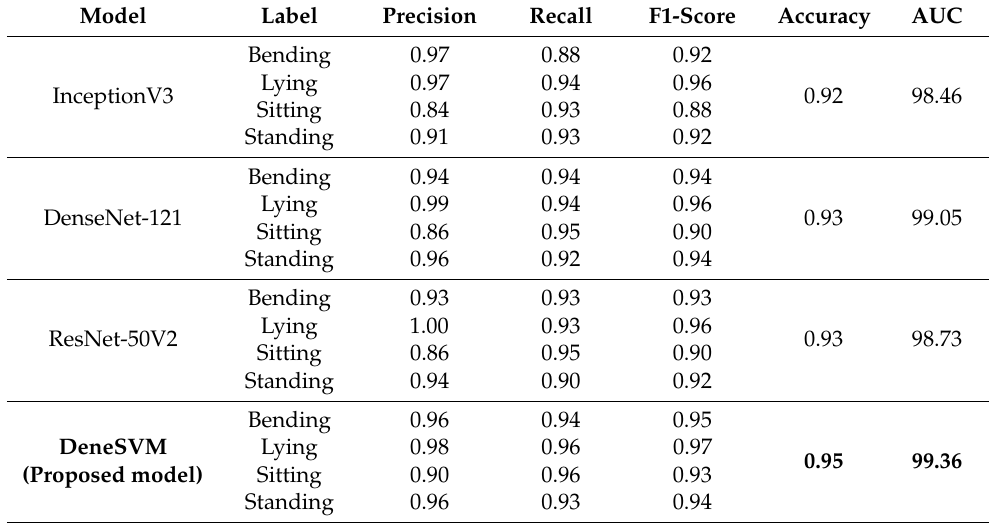
Table 6. Results of the performance evaluation obtained from Testing Dataset.